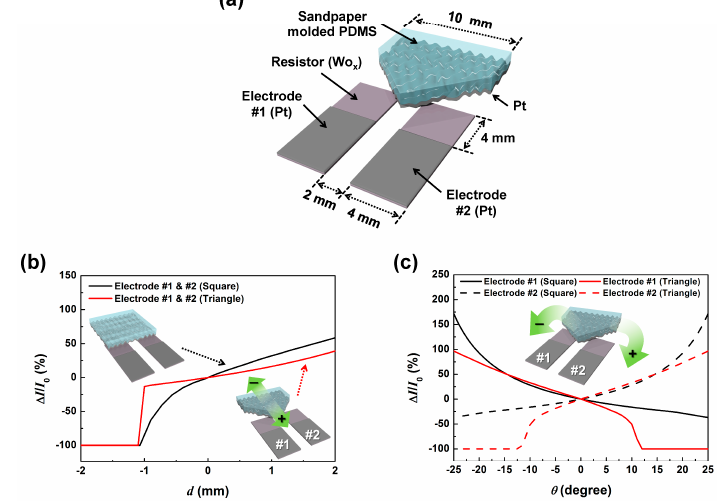
Figure 3. The dual electrode SMP (dSMP) sensor; ( a ) a schematic diagram of the dSMP sensor; ( b ) the simulation results on the current change ratios ( Δ I / I 0 ) of the lower electrodes of the dSMP sensor depending on the triangular (black) and rectangular (red) shape of SMP by applied displacement, and ( c ) the simulation results on Δ I / I 0 of electrode no. 1 (solid) and no. 2 (dash) depending on the triangular (black) and rectangular (red) SMP shape. Insets show the schematic illustration of triangular and rectangular shape SMP, and the green arrows shows the movement direction.